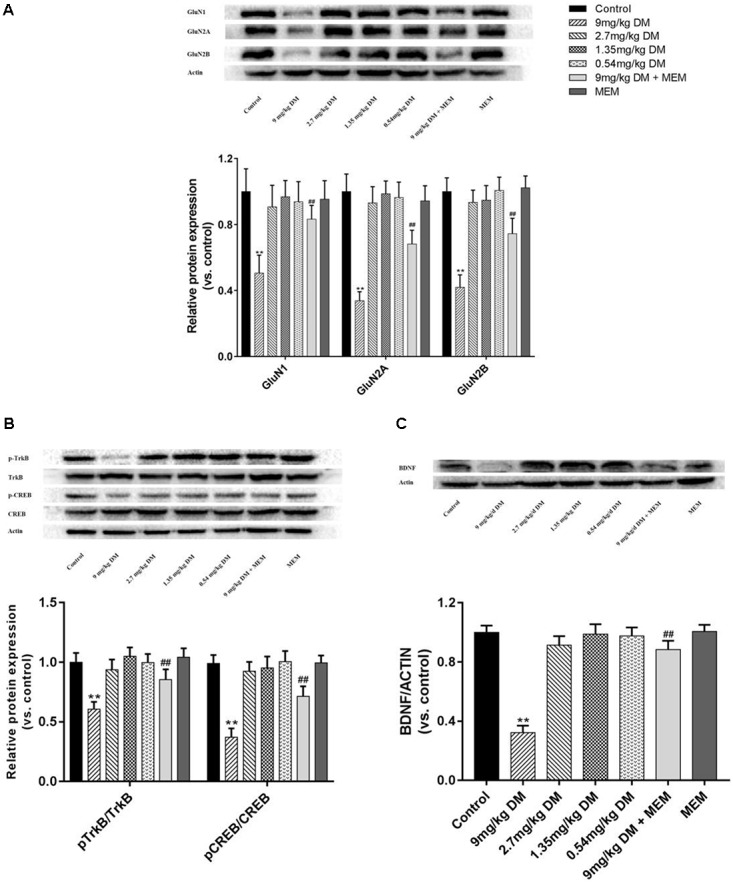
Western blot of protein expression of hippocampus GluN1, GluN2A, GluN2B (A), pTrkB, TrkB, pCREB, CREB (B), and BDNF (C) in the hippocampus of offspring. (A) Histogram showing the protein expression of GluN1, GluN2A, and GluN2B in the hippocampus (from left to right). Lanes (from left to right) represent the control, 9mg/kg DM, 2.7mg/kg DM, 1.35mg/kg DM, 0.54mg/kg DM, 9mg/kg DM + MEM, MEM groups. β-actin was used as control. (B) Western blot showing the protein expression of pTrkB, TrkB, pCREB, CREB and the column chart showing the quantification of the pTrkB/TrkB and pCREB/CREB ratio. (C) Western blot results of protein expression of BDNF in hippocampus of the offspring. β-actin was used as control. n = 12 in each group. ∗∗P < 0.01 when compared with control group. ##P < 0.01 when compared with 9 mg/kg DM group. DM: deltamethrin, MEM: memantine.